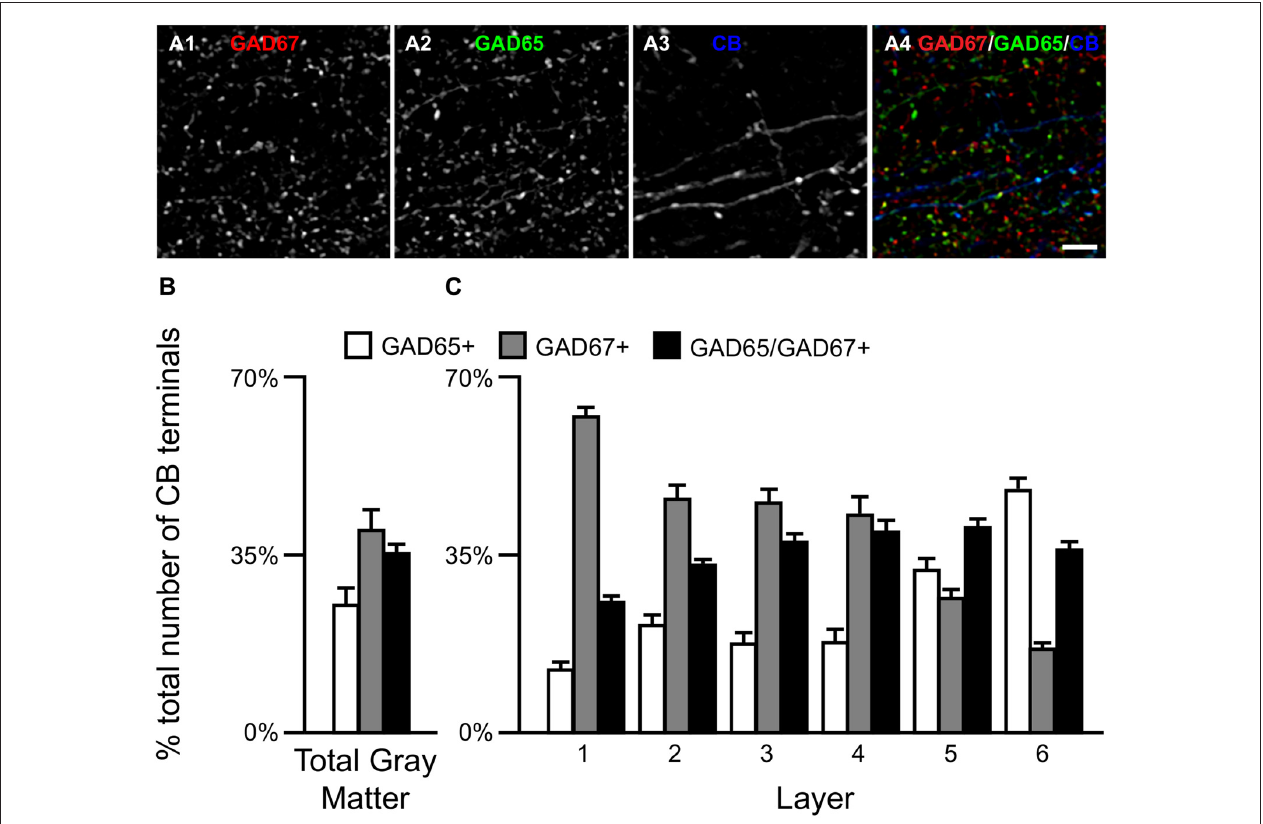
FIGURE 3 | The proportion of three CB/GAD+ terminal subpopulations differs across cortical layers. (A) Projection image (6 z-planes separated by 0.25 µ m) of a human PFC tissue section immunolabeled for CB, vGAT (not shown), GAD65 and GAD67. Gray scale images (A1–A3) are single channel images of the multichannel image (A4) and are representative of the immunohistochemistry labeling. Scale bar = 5 µ m. (B,C) Bar graphs showing the relative proportions of vGAT/CB+ terminals in PFC that were GAD65+, GAD67+, or GAD65/GAD67+. Error bars =